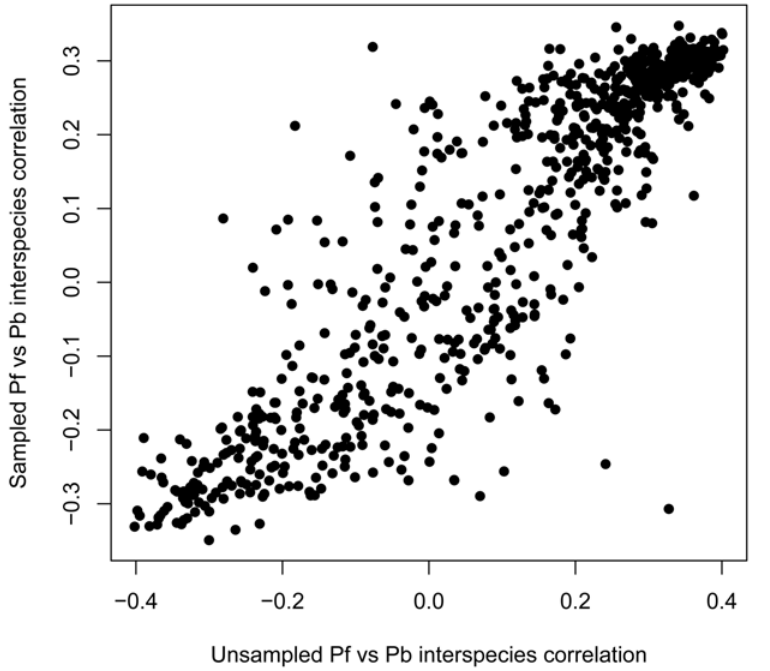
Figure 6. Interspecies correlations are not affected by differences in dimensionality between datasets. A comparison of the interspecies correlation coefficients obtained from the P. berghei and the unsampled and sampled P. falciparum expression datasets suggests the difference in dimensionality between the full P. falciparum and P. berghei datasets should not influence the results. The two sets of interspecies correlations have a Spearman rank-rho of 0.89 ( p-value , 2.2*10 2 16 ).